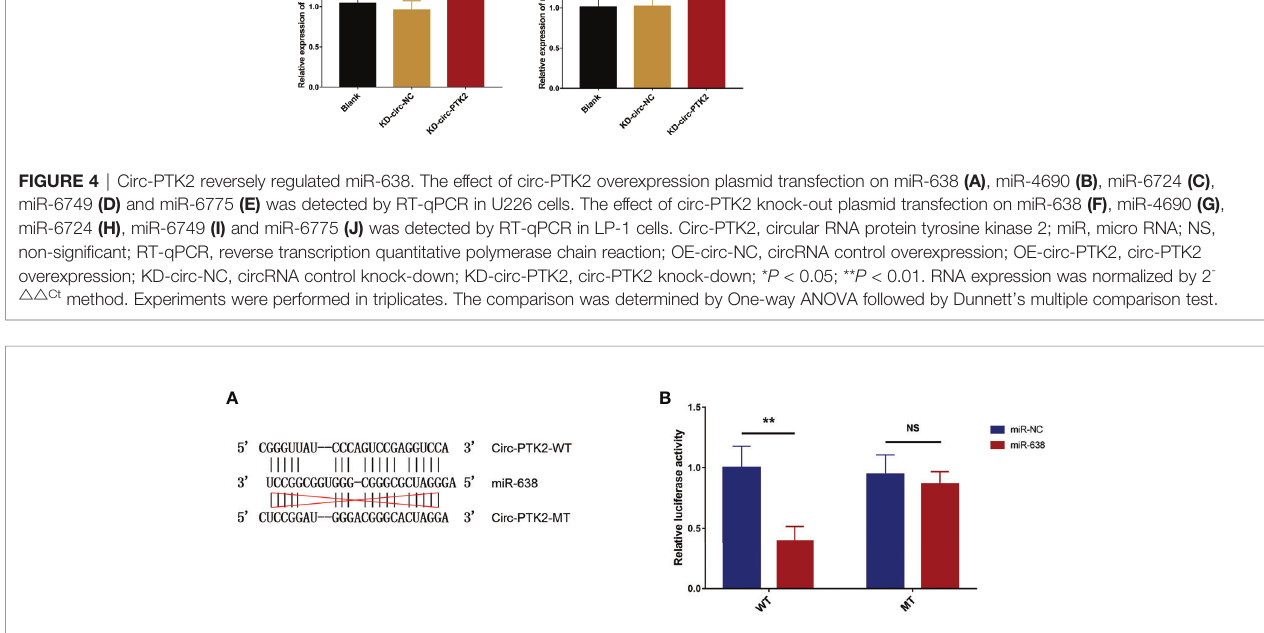
FIGURE 5 | Luciferase reporter assay. The related sequences of circ-PTK2 and miR-638 according to the potential binding site (A) . Comparison of relative luciferase activity between miR-638 and miR-NC circ-PTK2-WT cells; comparison of relative luciferase activity between miR-638 and miR-NC circ-PTK2-MT cells (B) . Circ-PTK2, circular RNA protein tyrosine kinase 2; miR-638, micro RNA 638; WT, wild type; MT, mutant type; NC, normal control; NS, non-signi fi cant; ** P <0.01. Experiments were performed in triplicates. The comparison was determined by The comparison was determined by One-way ANOVA followed by Tukey ’ s multiple comparison